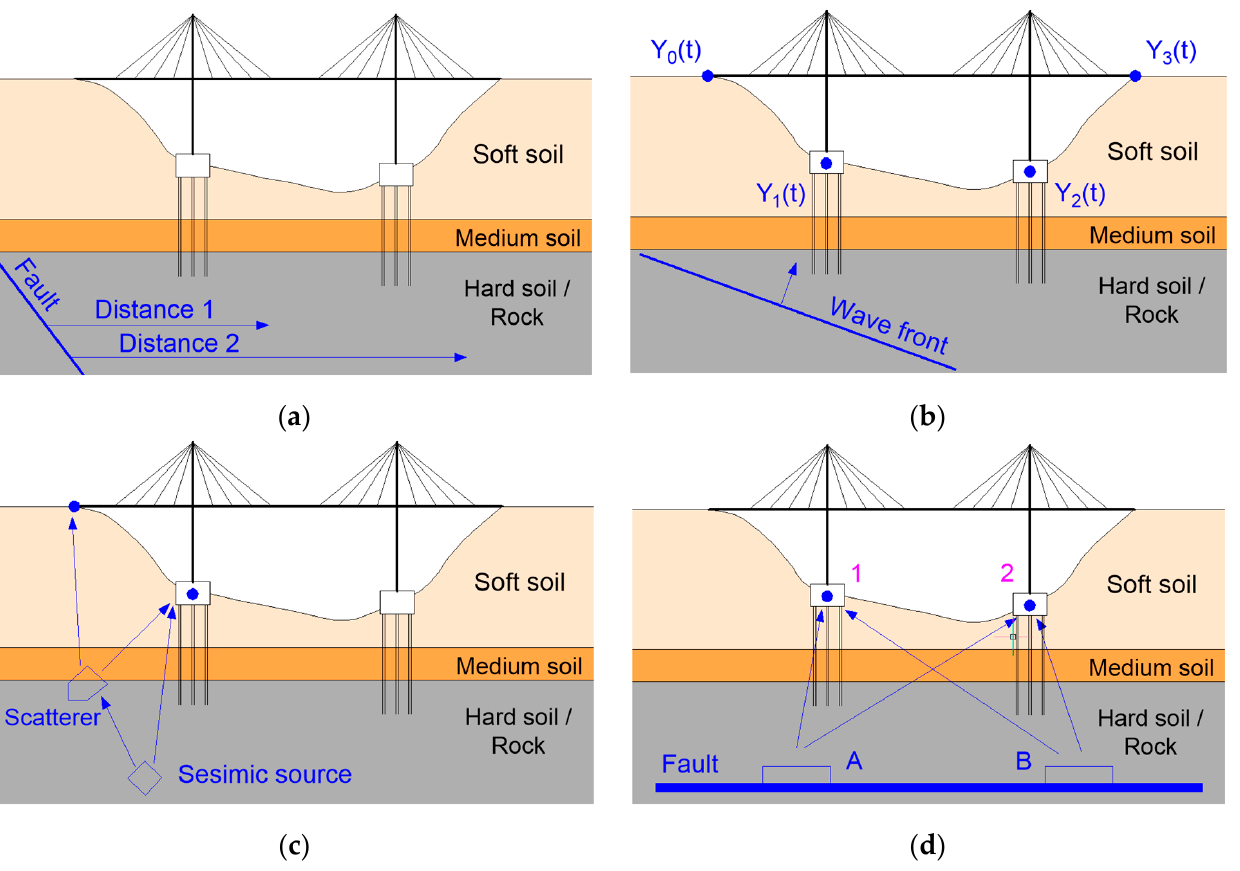
Figure 9. Sources of spatial variation for seismic ground motion: ( a ) attenuation effect; ( b ) wave passage effect; ( c ) ray-path incoherence effect; ( d ) extended source effect [57].